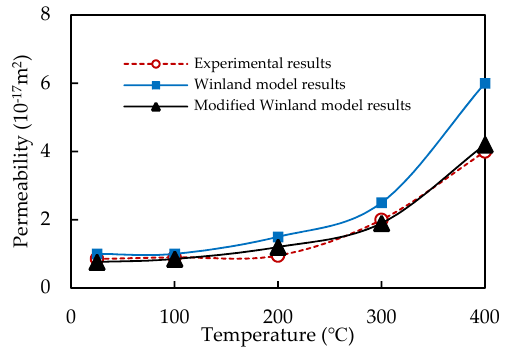
Figure 11. Permeability of granite under different temperatures.